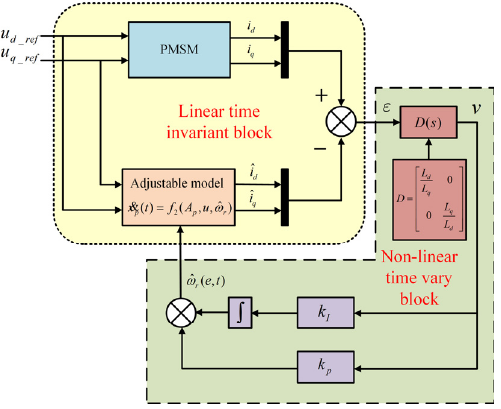
Figure 3. Structure of the estimator-based MRAO.